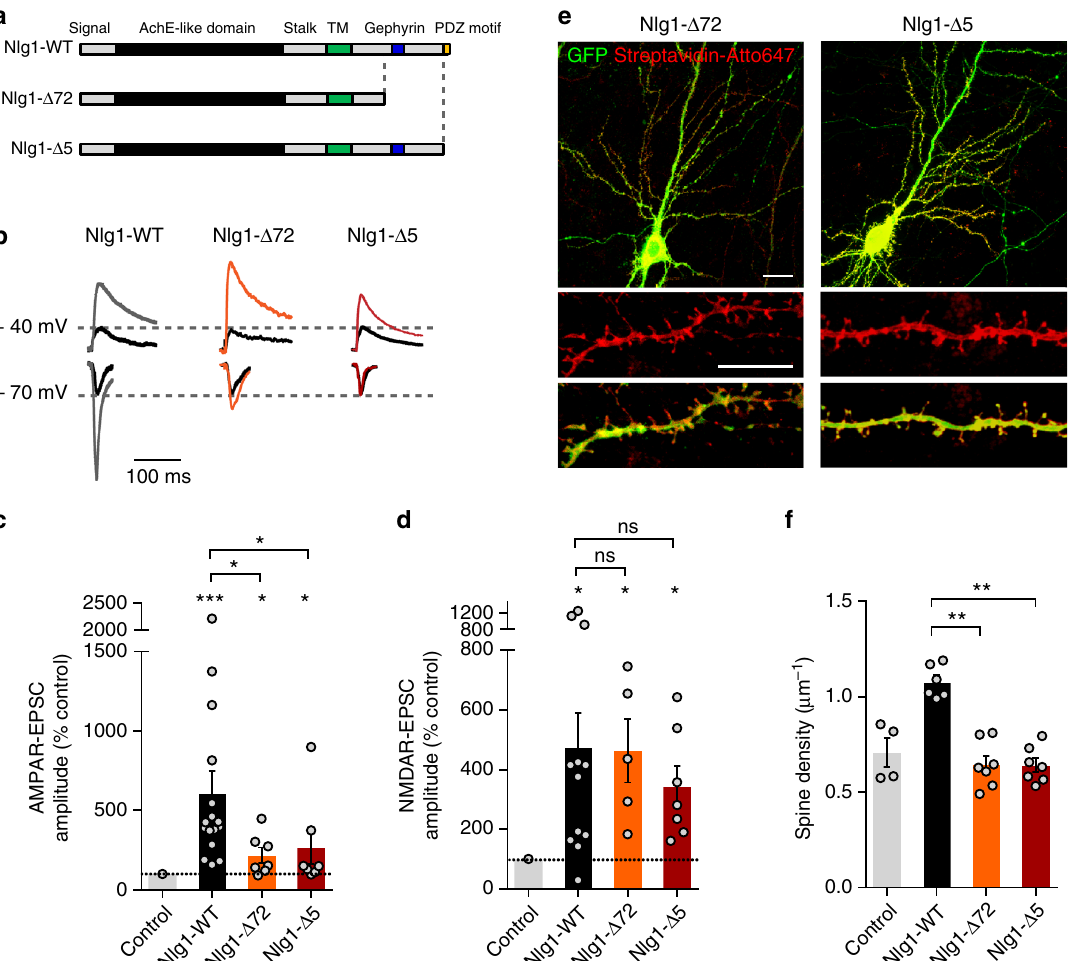
Fig. 5 Nlg1 C-terminal truncation affects AMPAR-dependent synaptic transmission and spine density. a Diagram of Nlg1 truncation mutants lacking the last 5 aa comprising the C-terminal PDZ domain-binding motif (Nlg1- Δ 5) or the last 72 amino acids also including the gephyrin-binding motif (Nlg1- Δ 72). TM: transmembrane domain. b Representative traces of evoked AMPAR- and NMDAR-mediated EPSCs recorded at − 70 mV and + 40 mV, respectively. Color sample traces correspond to neurons co-electroporated with GFP and Nlg1-WT, Nlg1- Δ 5, or Nlg1- Δ 72, respectively, while black traces correspond to control, unelectroporated neurons. c , d Average AMPAR- and NMDAR-mediated EPSC amplitudes, respectively, normalized to control (the dashed line indicates 100%, dot plots corresponds to different pairs, from 3 independent experiments). e Confocal images showing CA1 neurons from Nlg1 KO organotypic slices electroporated with GFP (green), BirA ER , and AP-tagged Nlg1- Δ 5 or Nlg1- Δ 72 which were labeled with streptavidin-Atto647 (red). Scale bars, 30 µ m (upper panels) and 10 µ m (lower panels). f Average spine density for CA1 neurons electroporated with EV, Nlg1-WT, Nlg1- Δ 5, or Nlg1- Δ 72 (dot plots corresponds to different cells, from 2 independent experiments). Data in graphs c and d were compared to the control condition by Wilcoxon matched-pairs signed rank test, and between themselves using one-way ANOVA followed by Tukey ’ s multiple comparison (ns: not signi fi cant, * P < 0.05, *** P < 0.001). Data in graph f were compared by a Kruskal – Wallis test followed by Dunn ’ s multiple comparison test (** P < 0.01). Data